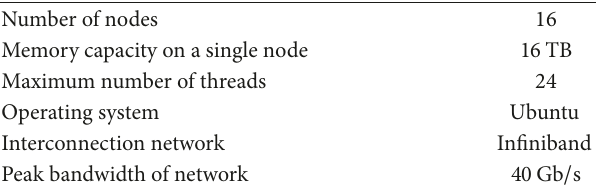
Table 3: Experimental environment for scalability